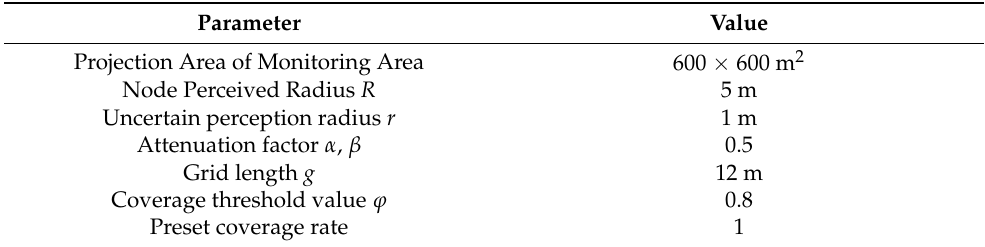
Table 2. Simulation